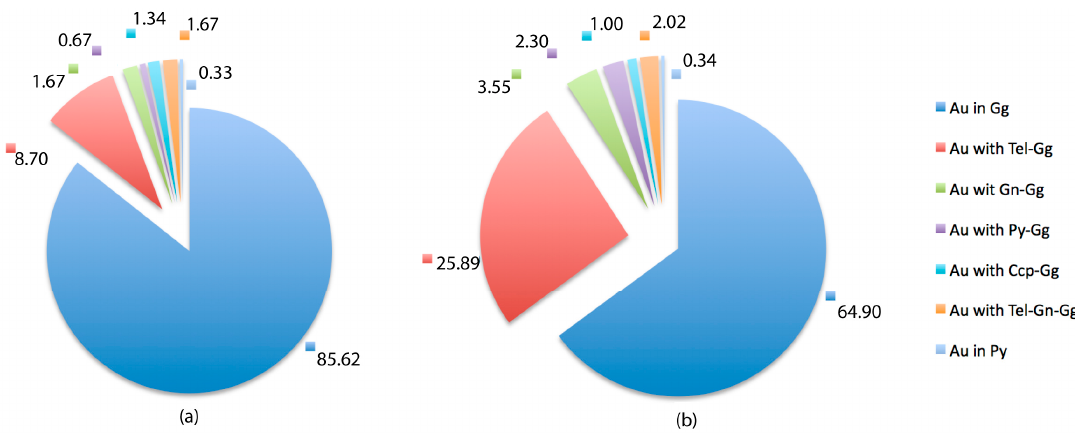
Figure 8. Pie charts showing frequency distribution of type of mineral association of gold in polished sections MB-21 and MB-21b: ( a ) as percent of total number of gold grains; and ( b ) as proportion of area of gold grains ( i.e. , % volume gold). Table 3. Number of gold grains measured according to their mineral association and gold size passing